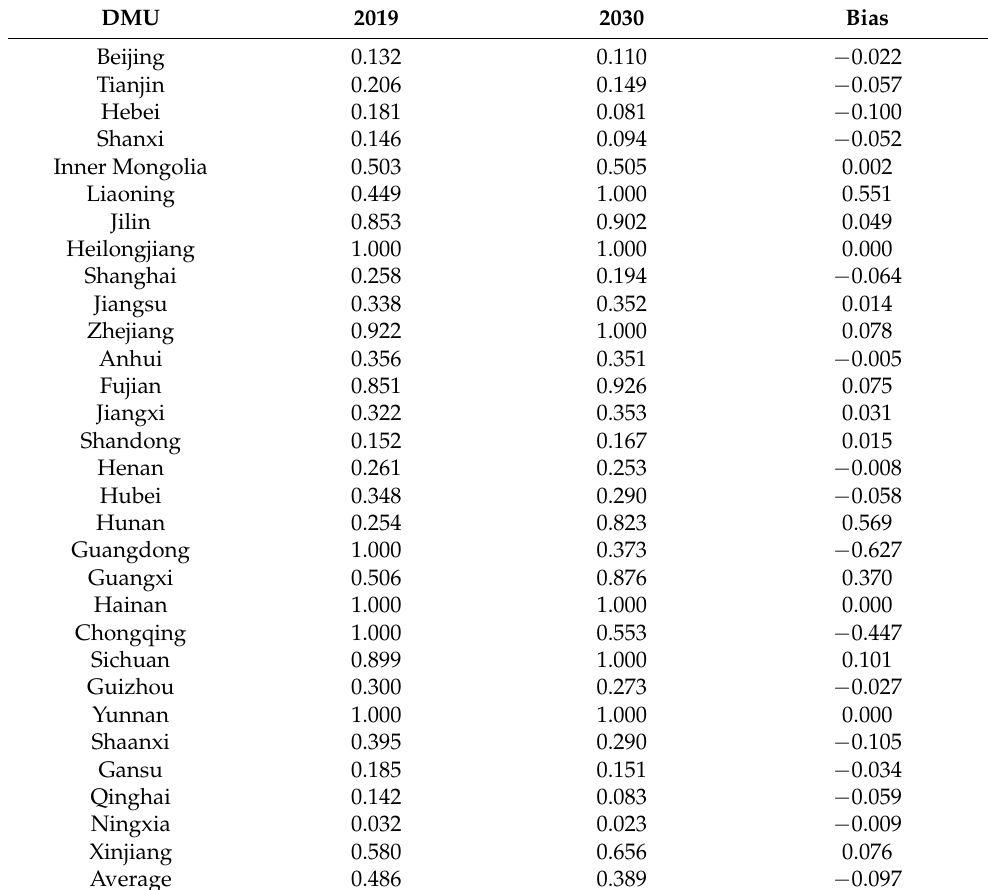
Table 4. CCR efficiency and deviation in 2019 and